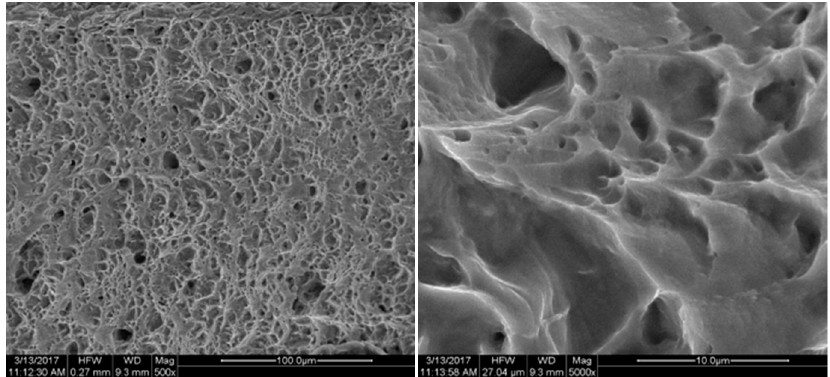
Figure 18. X-axis fracture under the tension speed of 80 μ m/min.